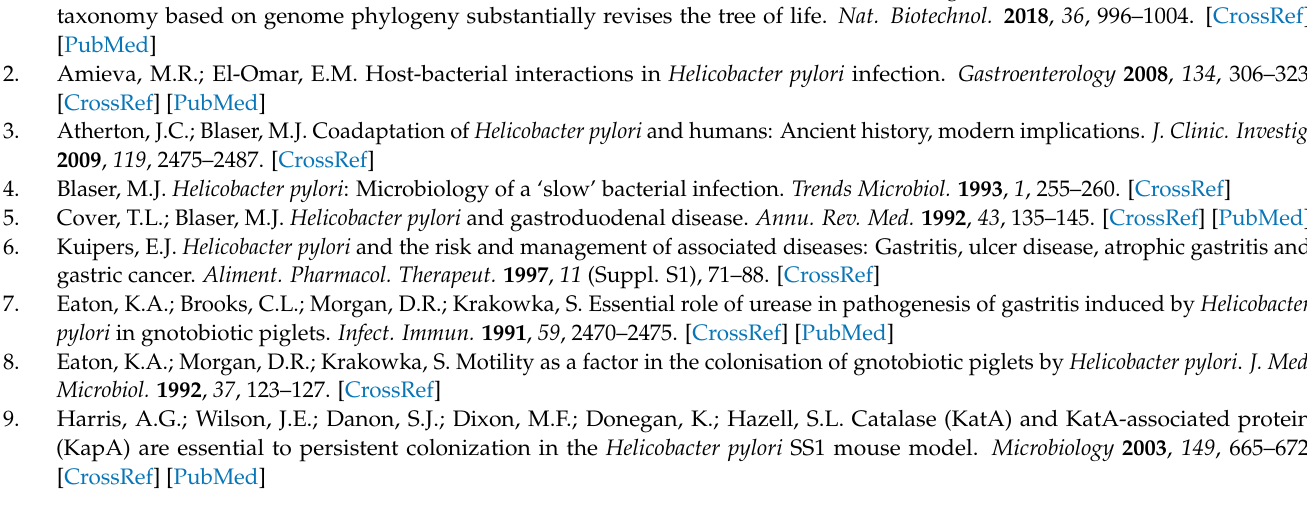
Figure S2: Digestion of gDNA from wild-type H. pylori G27 and B128, and mutants that lack the M.Hpy99III homolog, Figure S3: Sequence logo for GCGC-containing promoters in H. pylori BCM- 300 that may require the methylation of the GCGC motif for optimal activity, Figure S4: